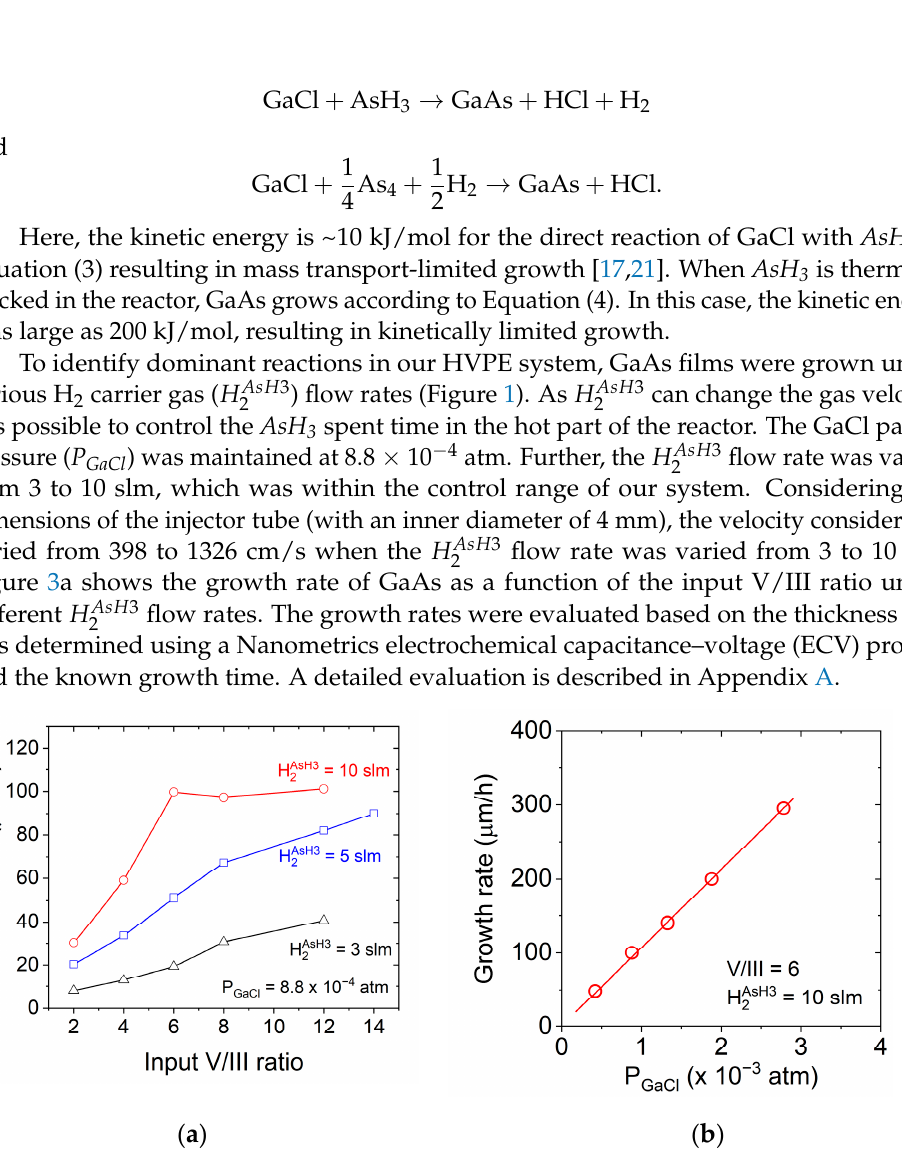
flows as a function of ( a ) V/III ratio and ( b ) P GaCl 2